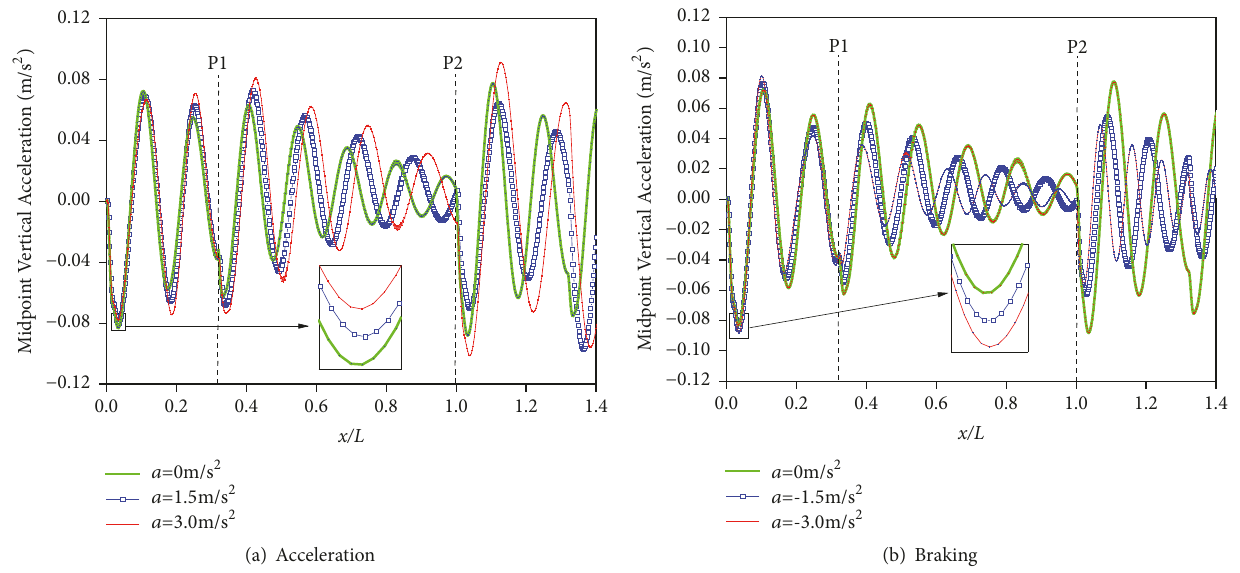
Figure 11: Vertical acceleration of midpoint of simply supported beam during varied vehicle